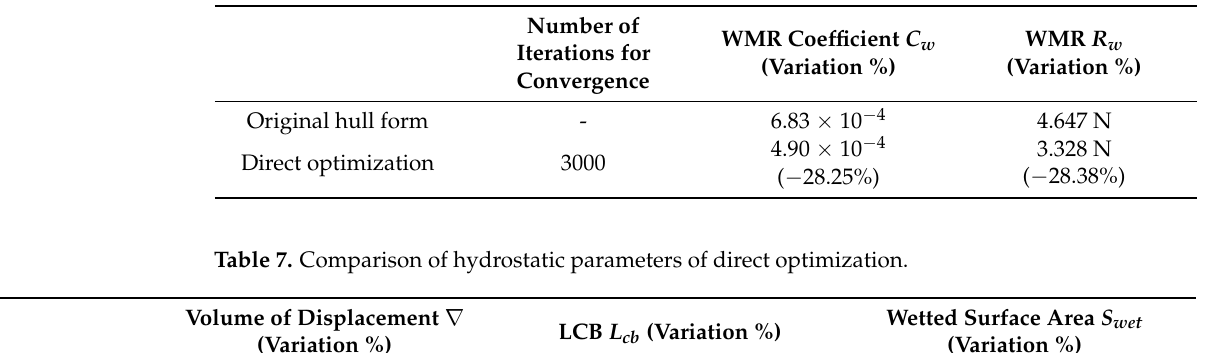
Table 6. Optimization results of direct optimization.